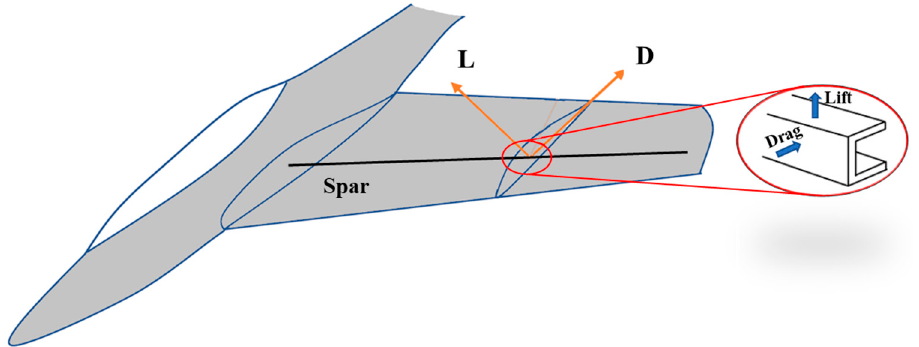
Figure 2. Wing spar under in-plane and edgewise flexural loading.